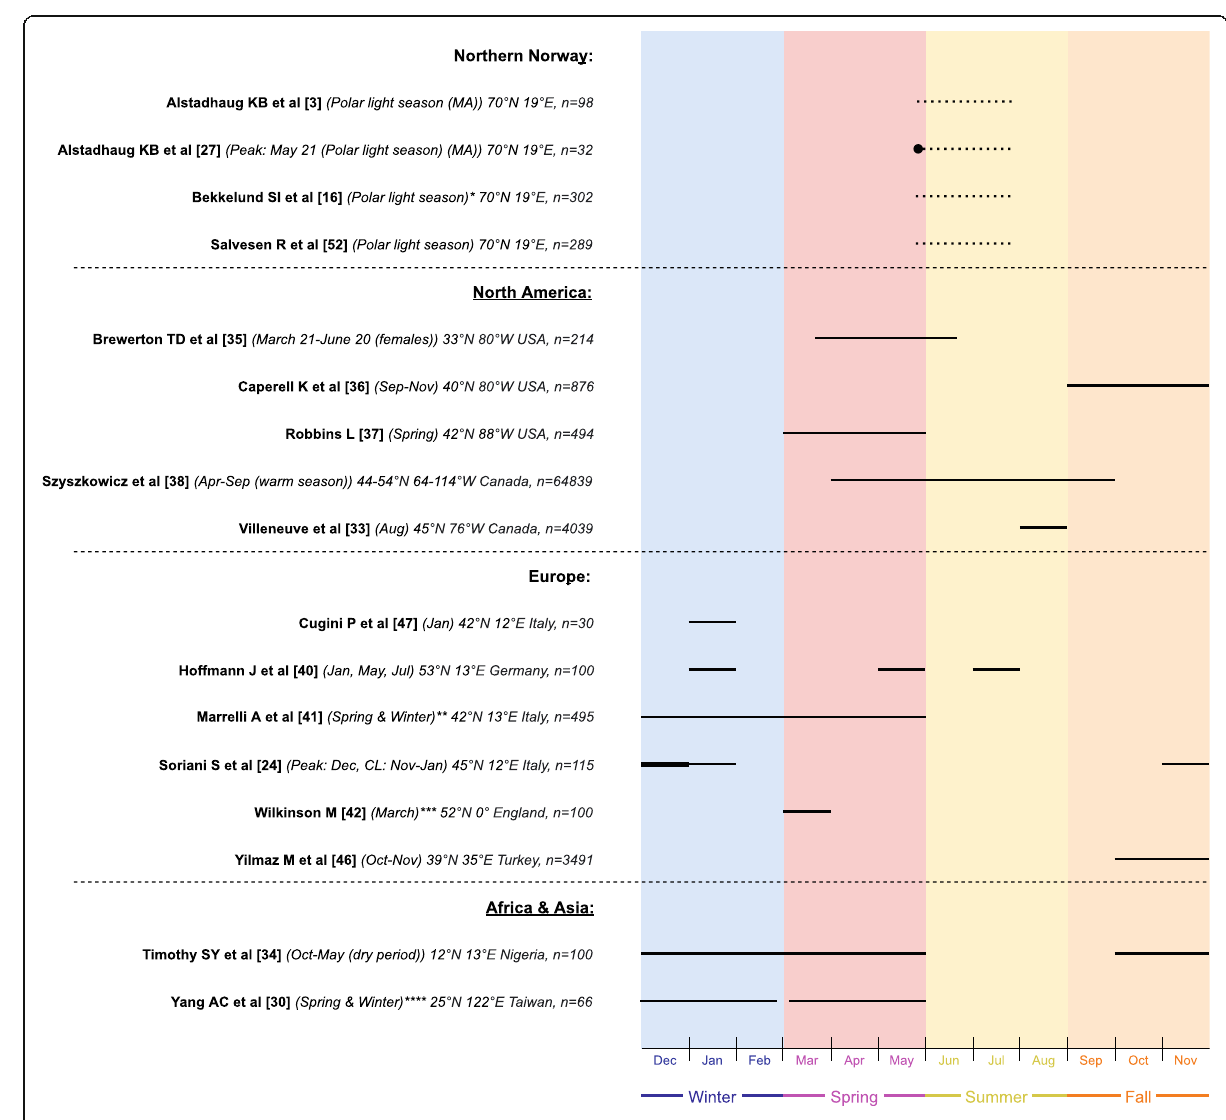
Fig. 4 Seasonal distribution of migraine attacks. Horizontal black lines indicate the reported time of year for peak in migraine attack frequency. Broken lines represent estimated dates based on definition of the polar light season in Tromsø (May 21st – July 21st ) [27] as exact dates were not specified by authors. Four studies on the seasonal distribution reported no peak of migraine attack frequency throughout the year [18 – 21]. Black dot indicates peak date. n: total sample size, N: north (latitude), E: east (longitude), W: west (longitude), MA: migraine with aura. MO: migraine without aura. CL: confidence level. *Data only obtained by those who answered yes to experiencing a seasonal variation of migraine attacks. **Results estimated from figure. Increased headache frequency in spring is more prevalent for MA compared to MO patients. *** This study followed patients for two consecutive years. In the first year, there was no pattern in regard to distribution of migraine attack frequency. In the subsequent year, there was however a monthly variation of attack frequency with a peak in March. **** Temperature sensitive patients showed migraine attack frequency peak in winter and non-temperature sensitive patients had more migraine attacks during